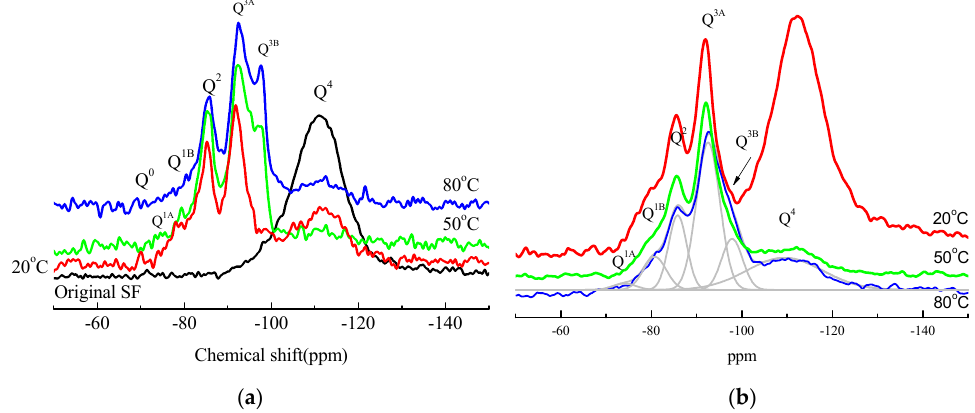
Figure 18. 29 Si MAS NMR spectra of SF and MgO-SF pastes prepared using MgO calcined at 1450 °C after 28 d: ( a ) MgO calcined for 30 min and ( b ) MgO calcined for 2 h. Table 6. Relative intensities of different silicon sites calculated using the 29 Si MAS NMR spectra of The 29 Si MAS NMR spectra of M-S-H gel produced at 20 ◦ C included a Q 3 signal at MgO-SF pastes ( δ 29 Si in ppm ± 0.6 ppm). − 92.6 ppm with a shoulder at − 97.7 ppm; a Q 2 signal at − 85.6 ppm; and two Q 1 signals at − 75.4 ppm and − 80.0 ppm. The fast decrease in Q 4 resonance is in agreement with the decrease in or disappearance of the three absorption bands shown in the SF FTIR spectra.